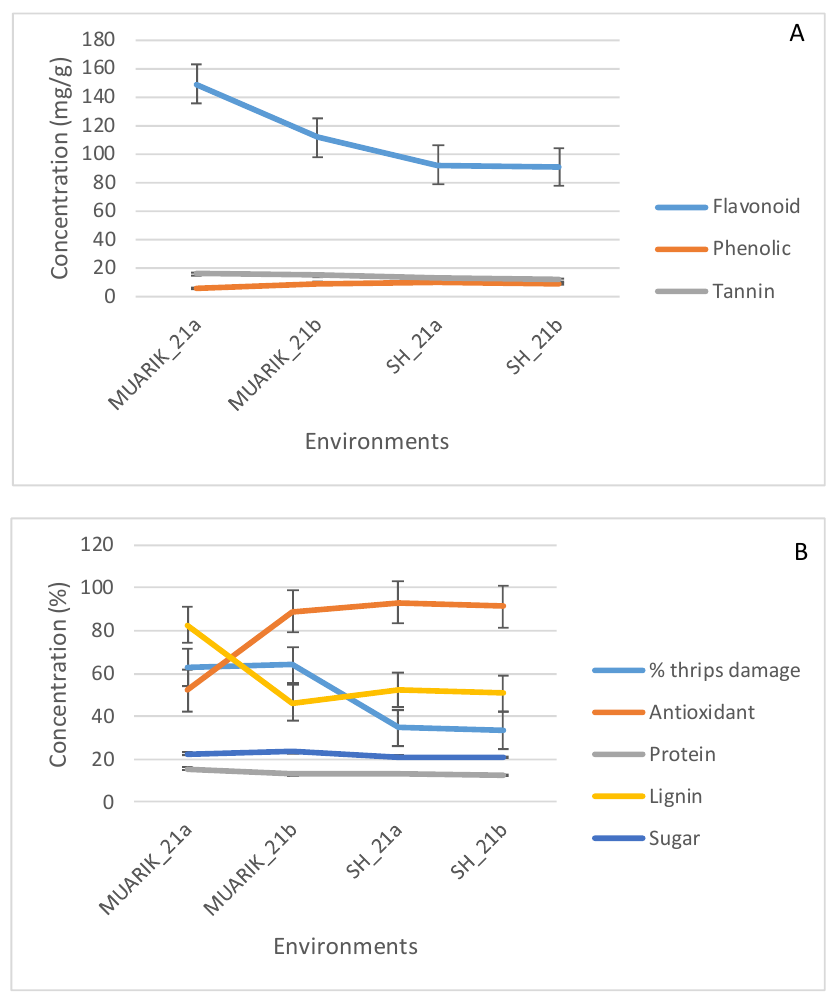
Figure 2. The trends in secondary metabolite concentrations ( A , B ) and thrips damage ( B ) in cowpea evaluated in the field (MUARIK) and screen house (SH) experiments.